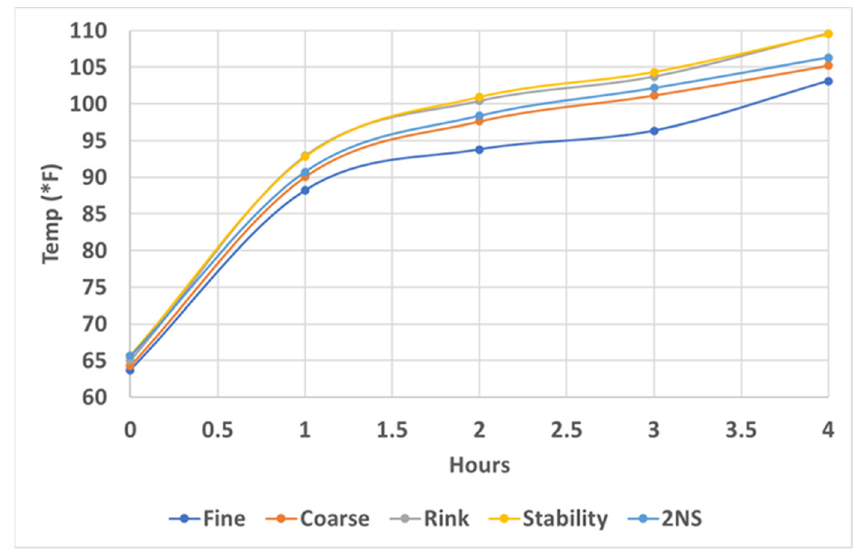
Figure 4. Plot of the average change in temperature over time for each of the five soils.